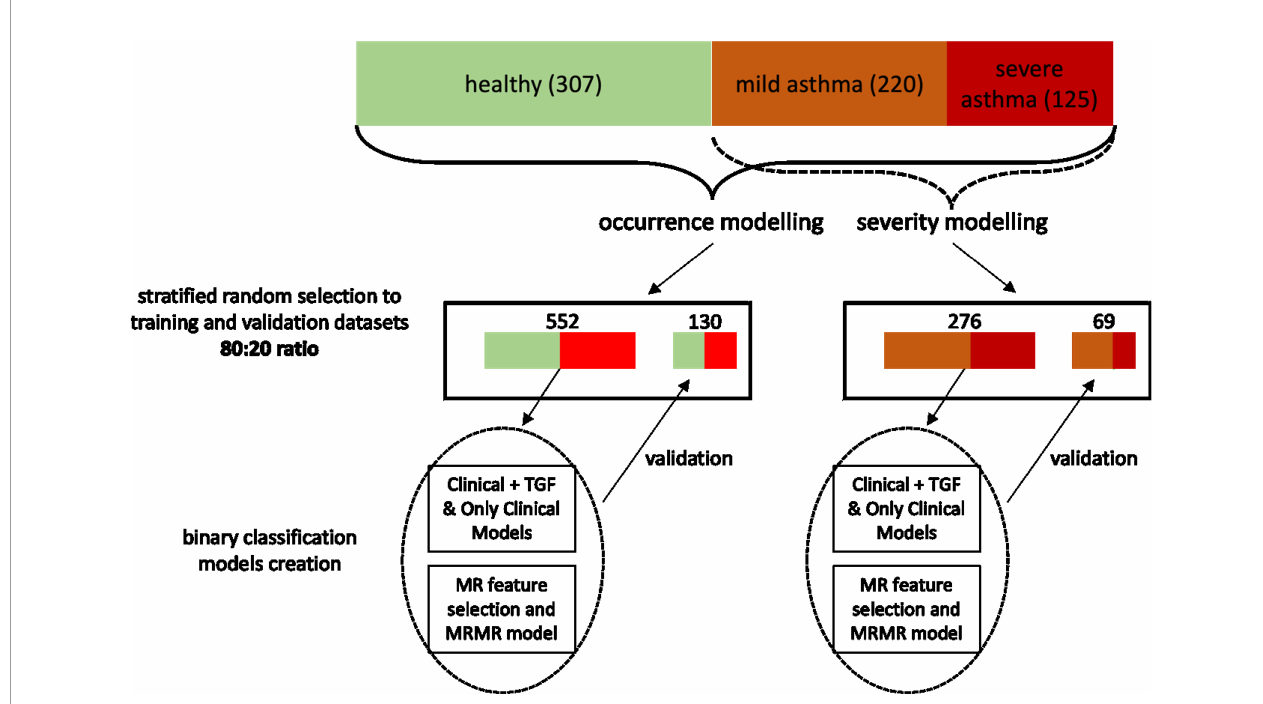
FIGURE 1 | The fl owchart showing the pipeline of model development and validation. I con fi rm that all methods were performed in accordance with the relevant guidelines and